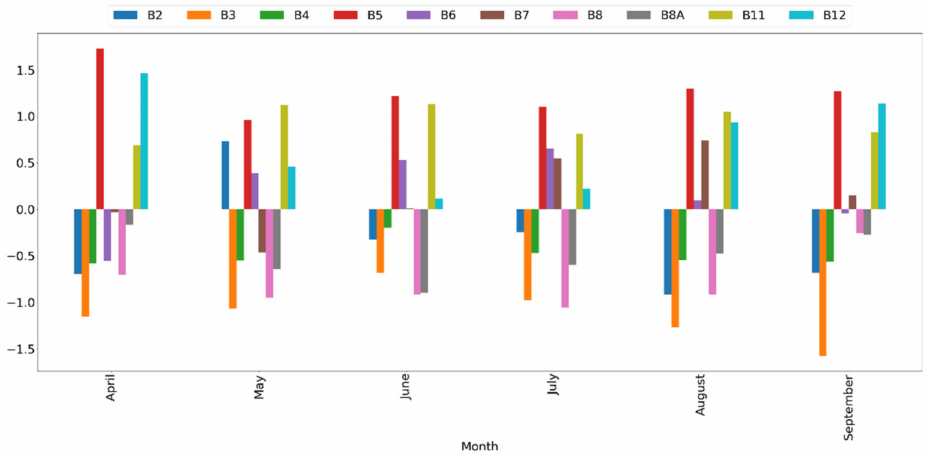
Figure 5. Standardized variable importance of Sentinel-2 spectral bands of the monthly classification models.